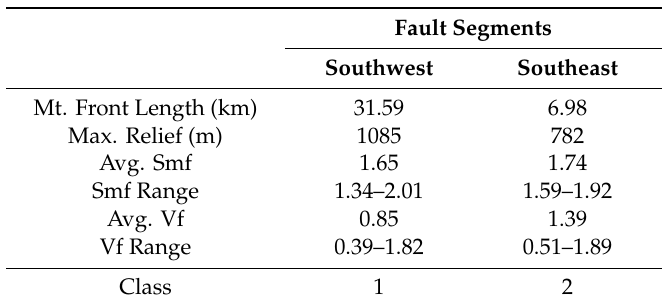
Table 2. The relative tectonic activity subdivision of the two segments of the Manzai Ranges using geomorphological indices, i.e., mountain front sinuosity (S mf ) and valley floor (V f ). The division is based on a classification scheme by Bull [46] and Keller and Pinter [48]. Class 1 defines active tectonic while class 2 is moderately